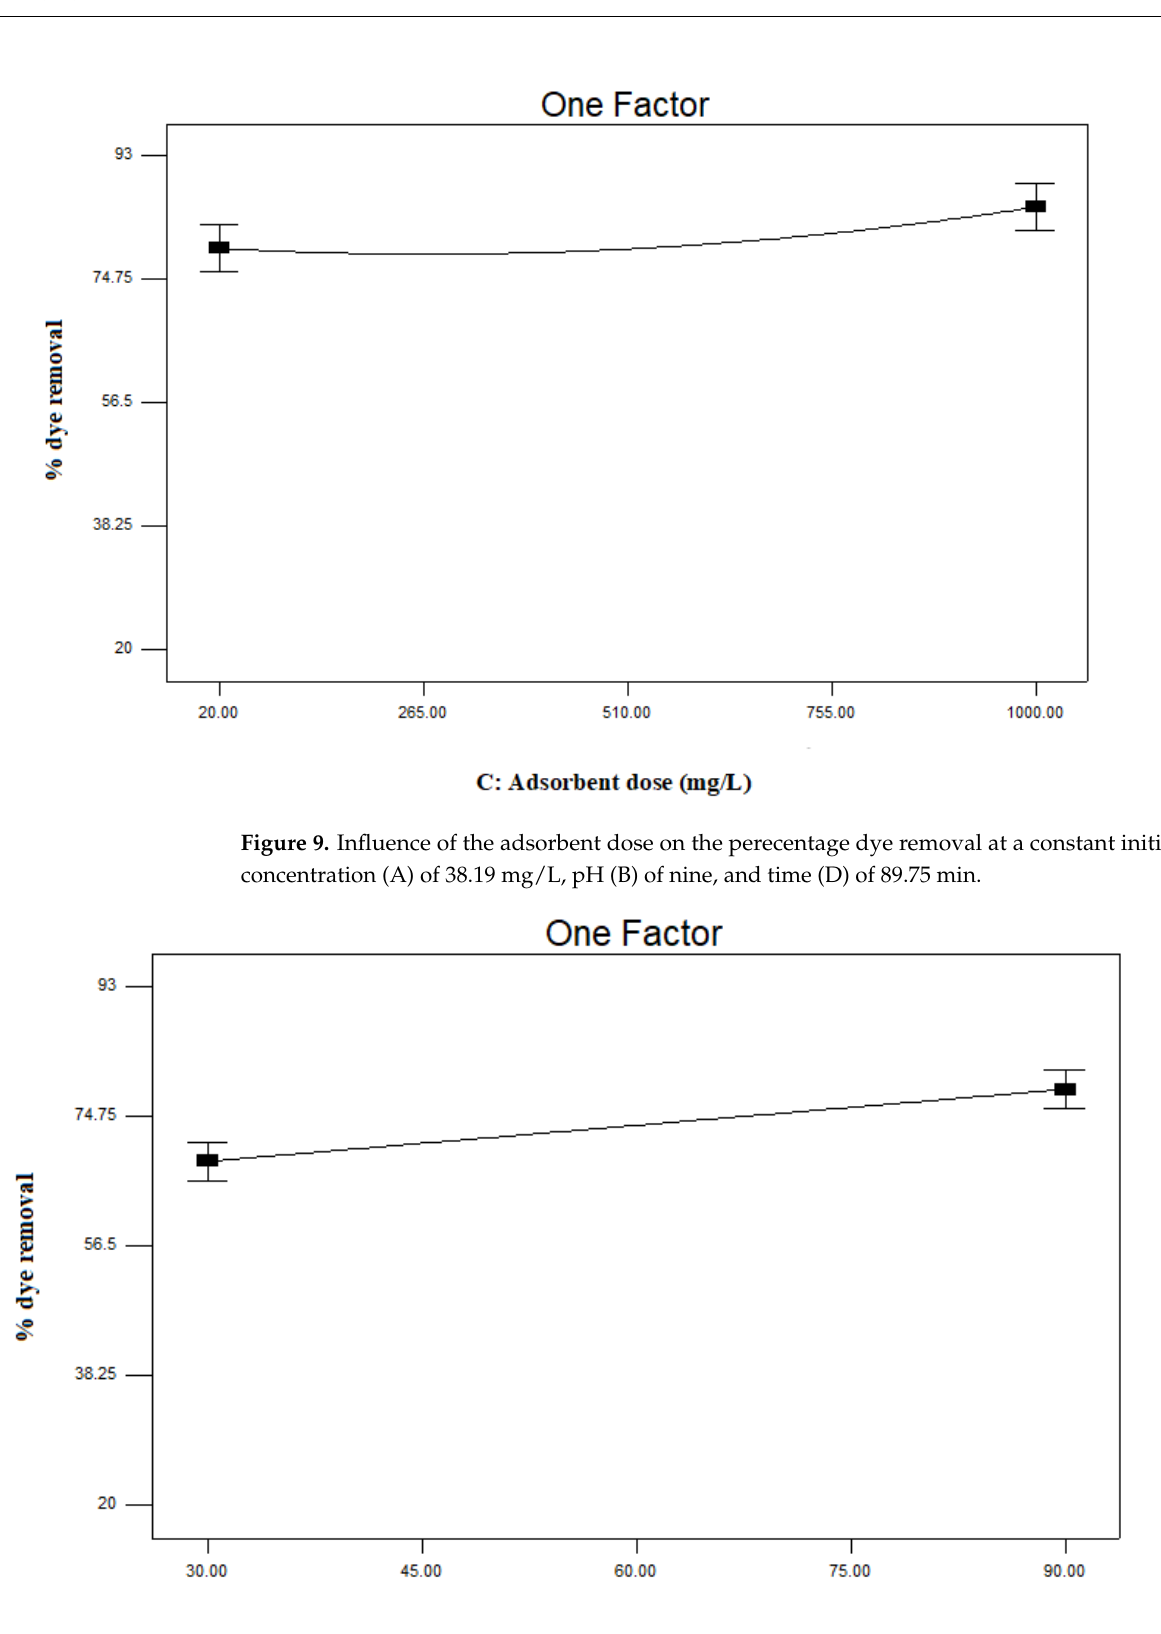
12 of 22 Figure 8. Effect of the solution’s pH on the perecentage dye removal at a constant initial dye con- centration (A) of 38.19 mg/L, adsorbent dose (C) of 200 mg/L, and time (D) of 89.75 min. Figure 9 displays the influence of the adsorbent dose on the perecentage dye removal at an initial dye concentration (A) of 38.19 mg/L, pH (B) of nine, and time (D) of 89.75 min.